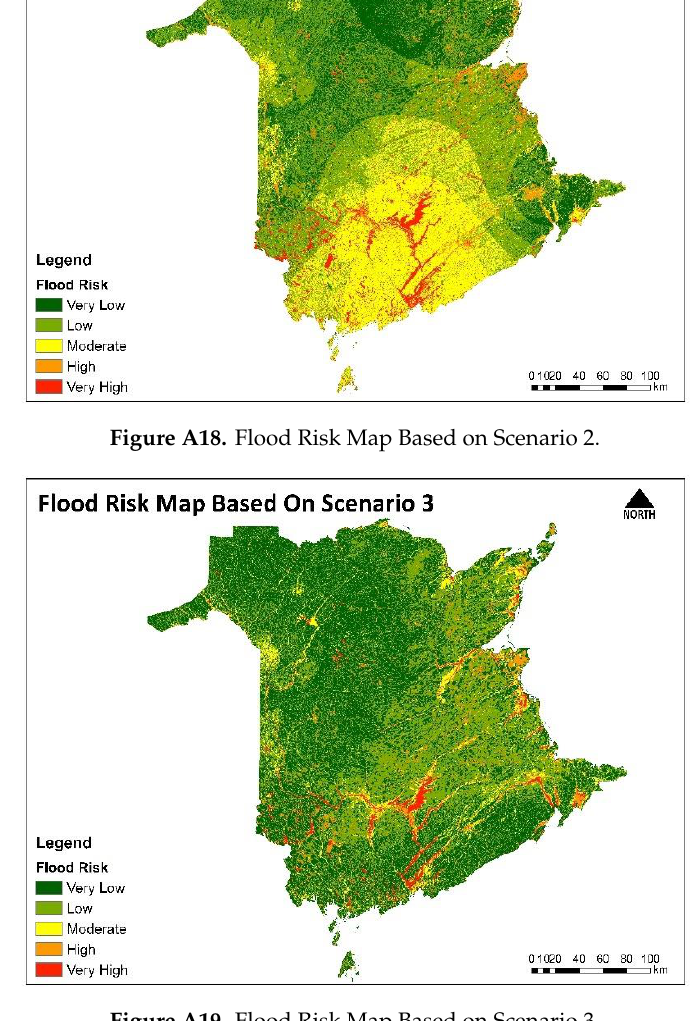
Figure A19. Flood Risk Map Based on Scenario 3.